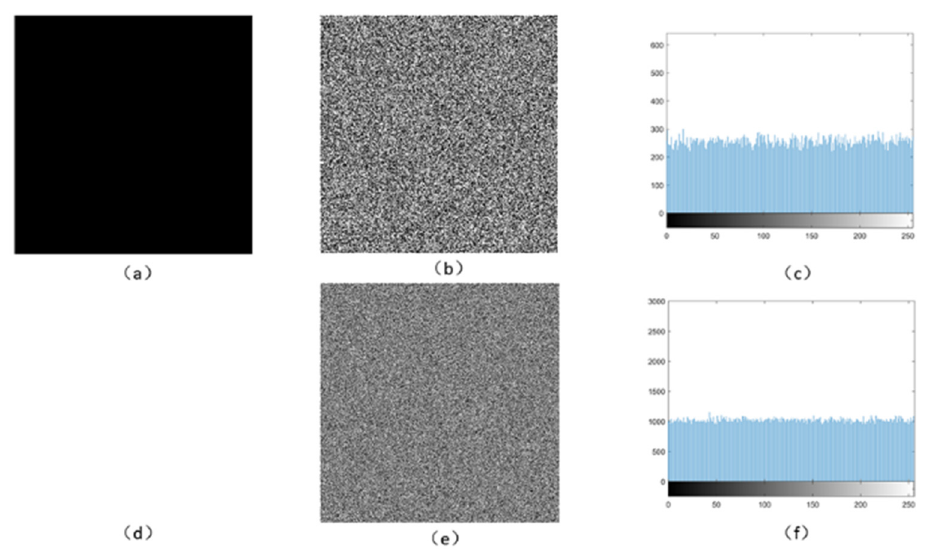
Figure 8. Experimental results of special images: ( a , d ) special image; ( b , e ) encrypted image; ( c , f ) cipher-text histogram. Table 7. Information entropy of special image and correlation of each direction. Relevance Information Entropy Level Vertical Diagonal All black cipher-text image 7.9973 − 0.0094 0.0098 − 0.0016 All white cipher-text image 7.9974 − 0.0169 − 0.0094